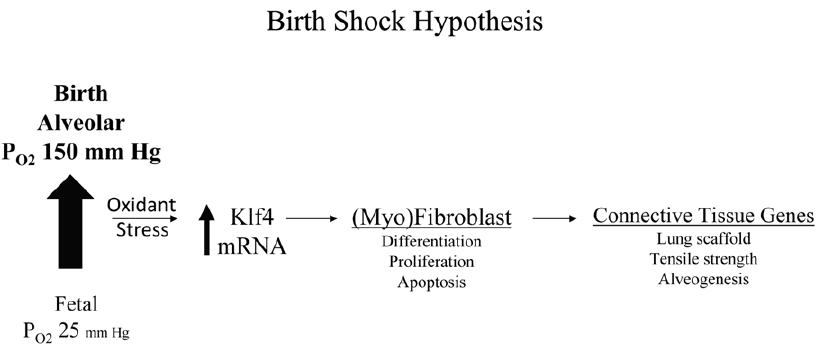
Figure 14. Birth shock hypothesis. We propose that the changing alveolar oxygen at birth changes the local redox state (birth shock) and thereby acts as a physiologic signal to induce Klf4 mRNA expression, which then regulates proliferation and apoptosis in fibroblasts and airway epithelial cells, and connective tissue gene expression and myofibroblast differentiation at the tips of developing alveoli.